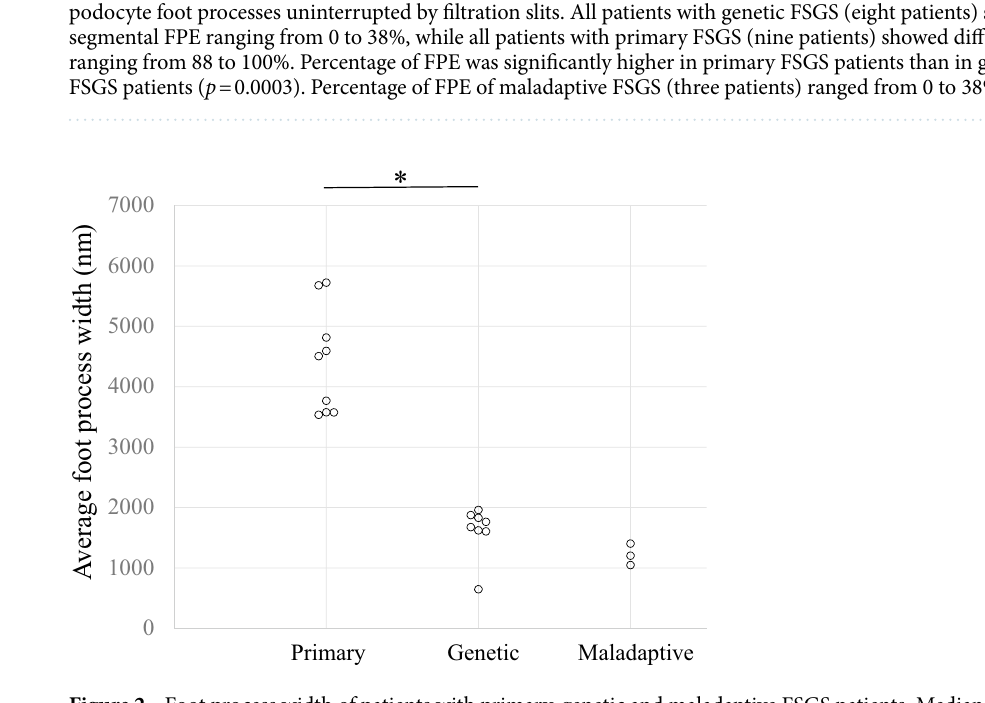
Because less patients with genetic FSGS patients showed nephrotic syndrome compared to primary FSGS patients (Table 1), we examined the relationships between the amount of proteinuria and the degree of FPE. The amount of proteinuria correlated with neither percentage of FPE ( r = 0.44; p = NS) nor FPW ( r = 0.39; p = NS). Literature review of articles and case reports describing the degree of FPE in genetic FSGS patients. A total of 1768 articles were identified using the predefined search strategy. By screening the study